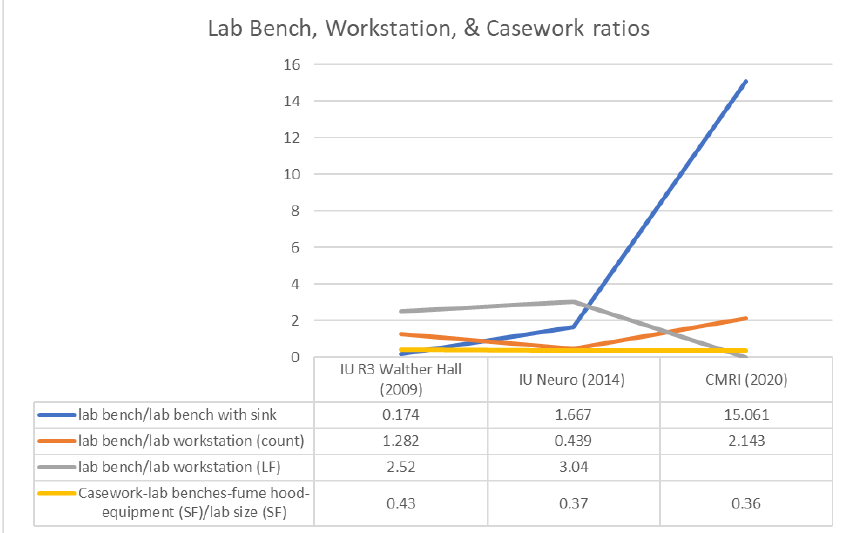
Figure 13 Lab bench, workstation, and casework trends across the